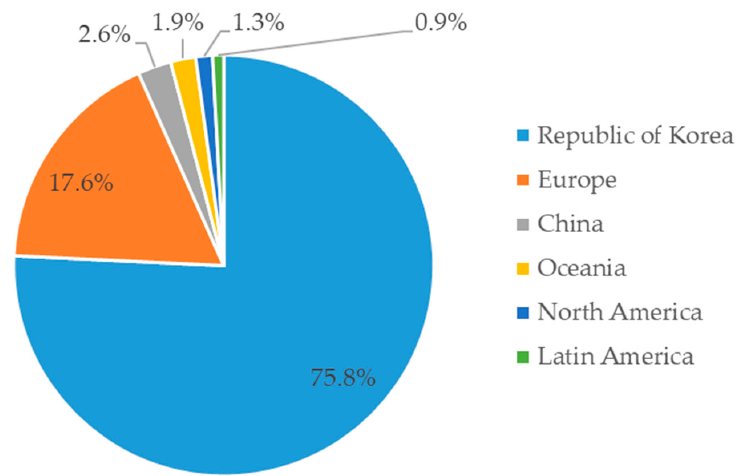
Figure 30. Cumulative GEHPs exported from Japan up to 2015.